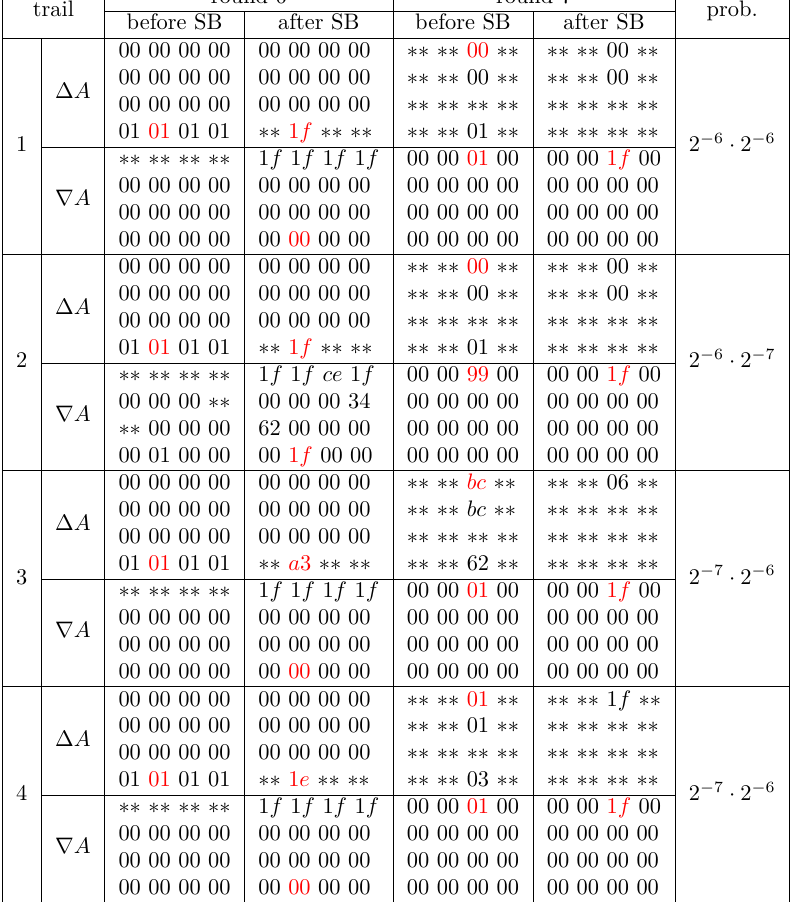
Table 4: Differential characteristic of the middle two rounds that is used in the boomerang attack against AES -192 in Section